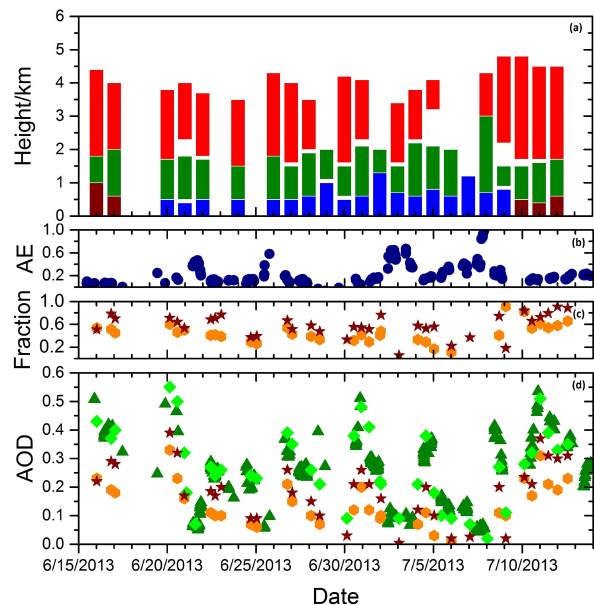
Figure 1. Time series of (a) aerosol layering during SALTRACE derived from POLIS lidar measurements during the evening mea- surement sessions (red indicates Saharan dust dominated aerosol layers, green indicates intermediate or mixed aerosol layers, blue indicates marine dominated aerosol layers and brown indicates mix- tures of Saharan dust and marine aerosols); (b) Ångström exponents between 440 and 870nm (blue dots) from CIMEL sun-photometer measurements; (c) the fraction of pure dust optical depth (orange) and total dust optical depth (brown stars) to the total aerosol op- tical depth (AOD); (d) AOD at 500nm derived from CIMEL sun- photometer measurements (dark green) and at 532nm derived from POLIS lidar measurements (light green) and optical depth of the pure dust layer (orange) and of the whole dust contribution in the atmospheric column (brown stars) at 532nm derived from POLIS lidar